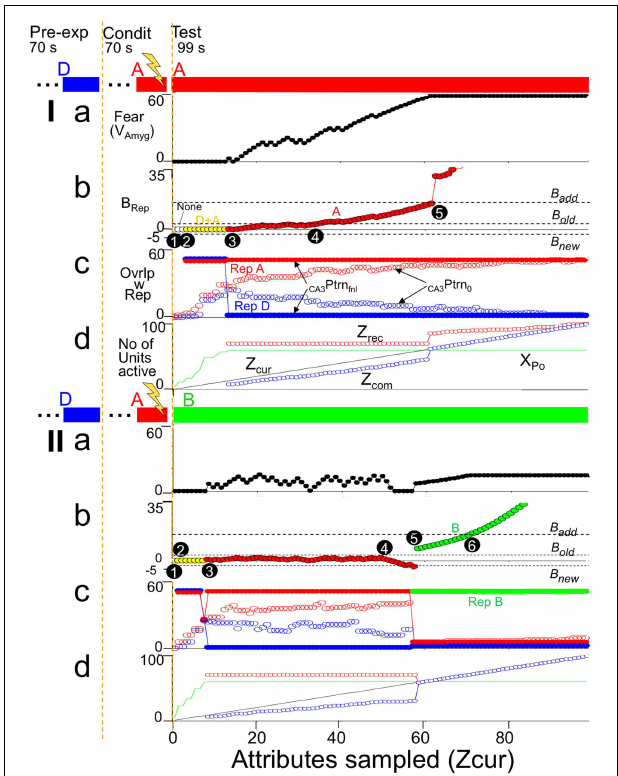
FIGURE 9 | Illustrative simulations. BACON was pre-exposed to context D (blue—70 samples) and then given a US at the end of 70 samples in a novel context A. Context A was maximally different from D (the only attributes common to them were the 50 attributes that were part of all contexts). A subsequent test session (which is what is shown in detail) was either (I) in context A or (II) in a partially similar context B (green—75 attributes common to A). The bars at the top of the figure indicate what context the automaton was in throughout the simulation. (a) Fear. (b) B Rep . The active representation that was controlling EC’ out activity and determining B Rep is indicated by marker color. (c) Overlap of active CA3 Ptrn o and CA3 Ptrn Fnl cells with each existing representation. (d) Z cur , Z rec , Z com , and X Po (i.e., number of cells active